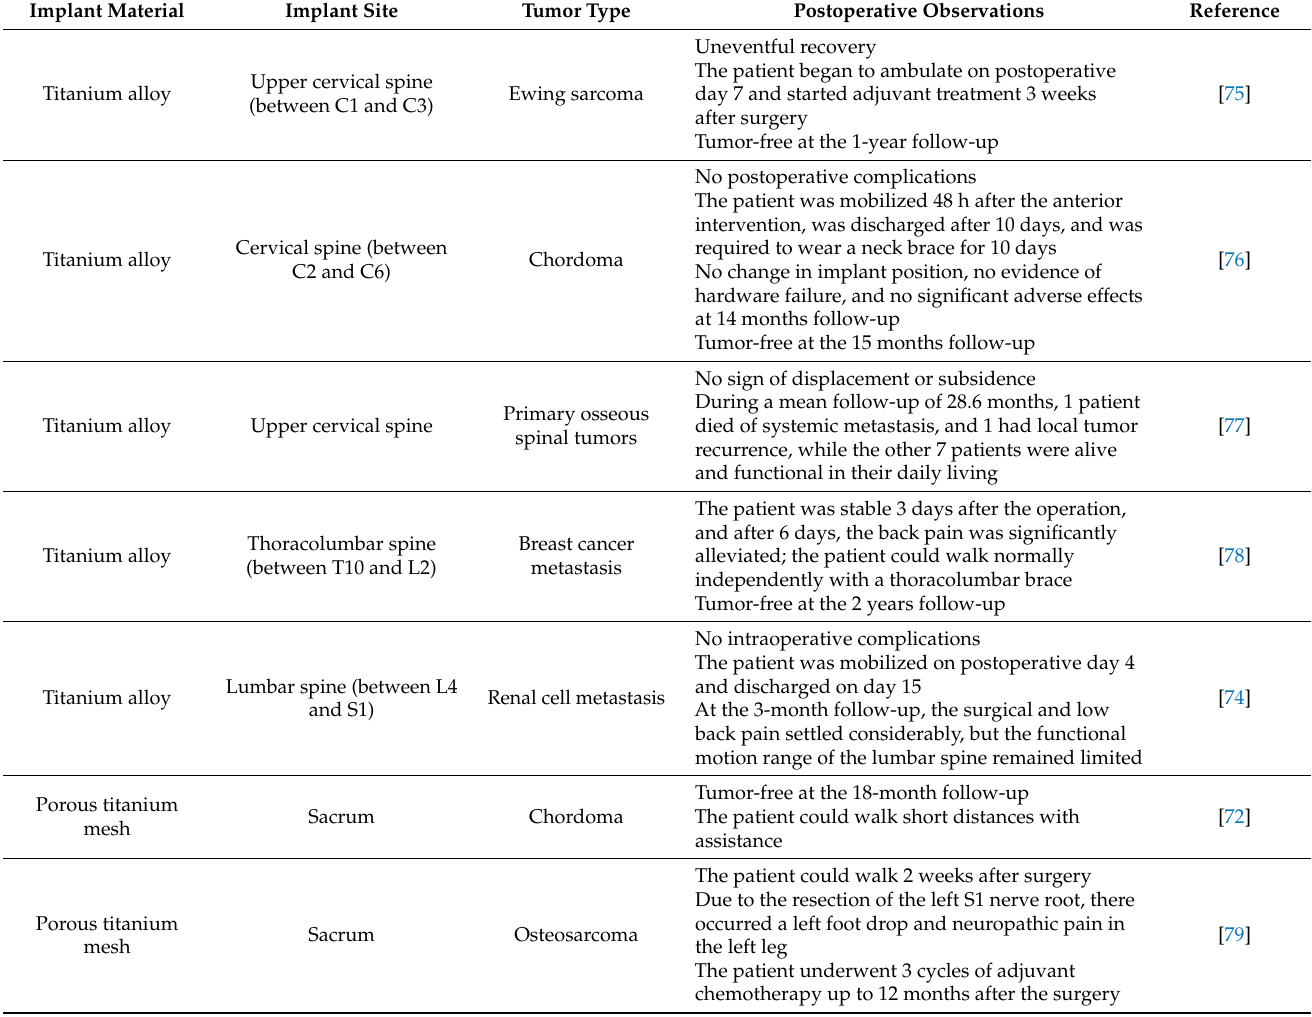
Table 2. Summary of discussed custom-made vertebral body